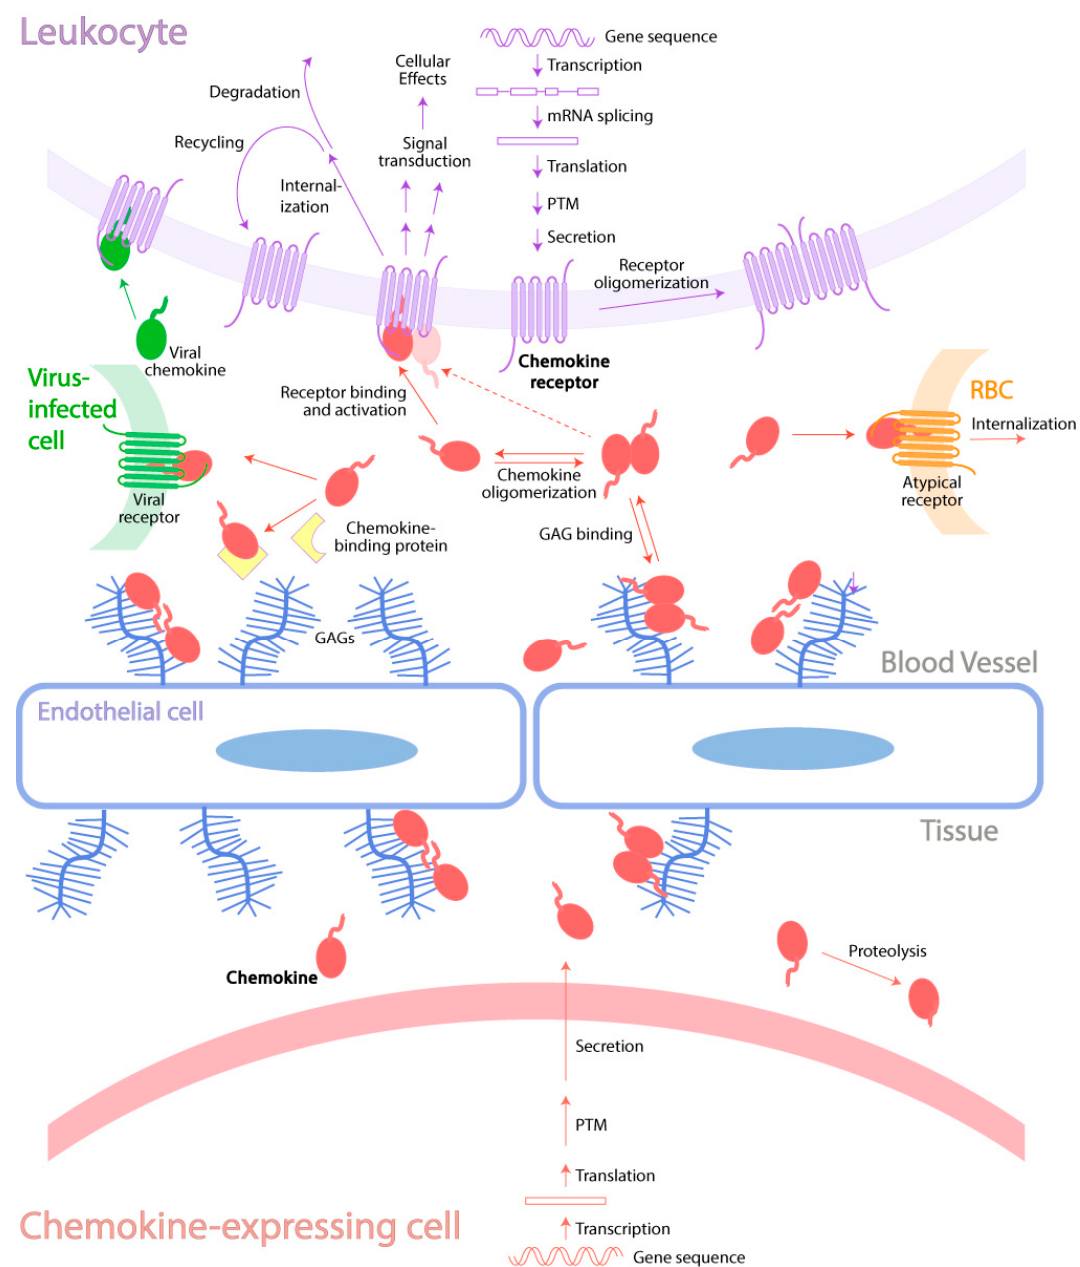
Figure 1. Schematic overview of regulation mechanisms of the chemokine-receptor network. Abbreviations: PTM: post-translational modification; RBC: red blood cell. Arrows in red, purple, green and orange indicate processes involving chemokines, chemokine receptors, viral chemokines and atypical receptors, respectively.